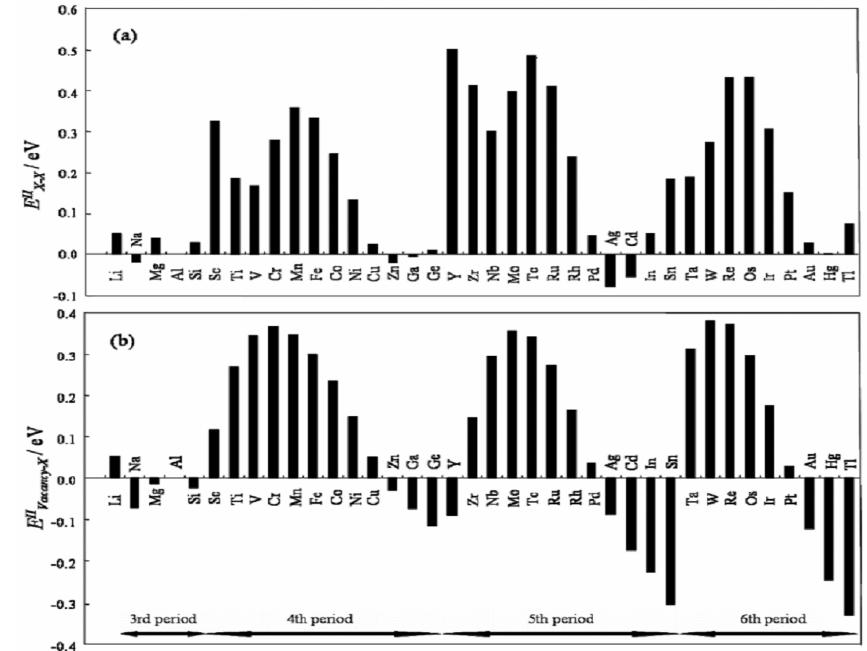
Figure 1. Two-body interaction energies between nearest-neighbor X atoms, E II X − X ( a ), and between nearest-neighbor X atom and vacancy, E II Vacancy − X ( b ) for various microalloying elements X in Al [17].